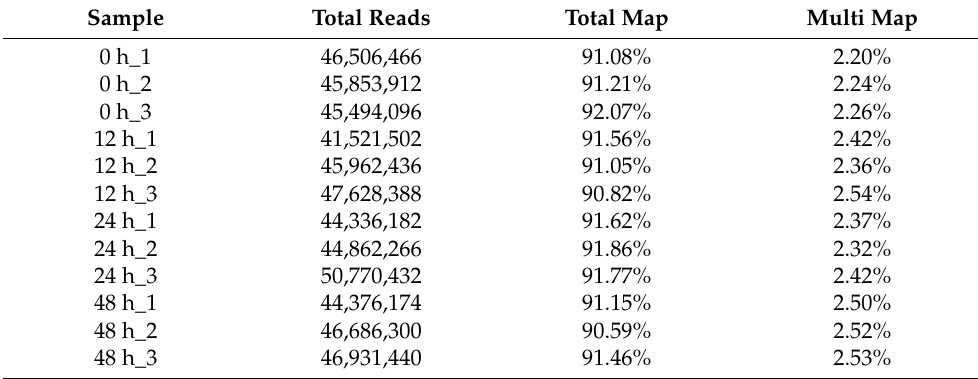
Figure 1. The lengths of the genes. Table 2. A comparison of each sample with the reference genome.